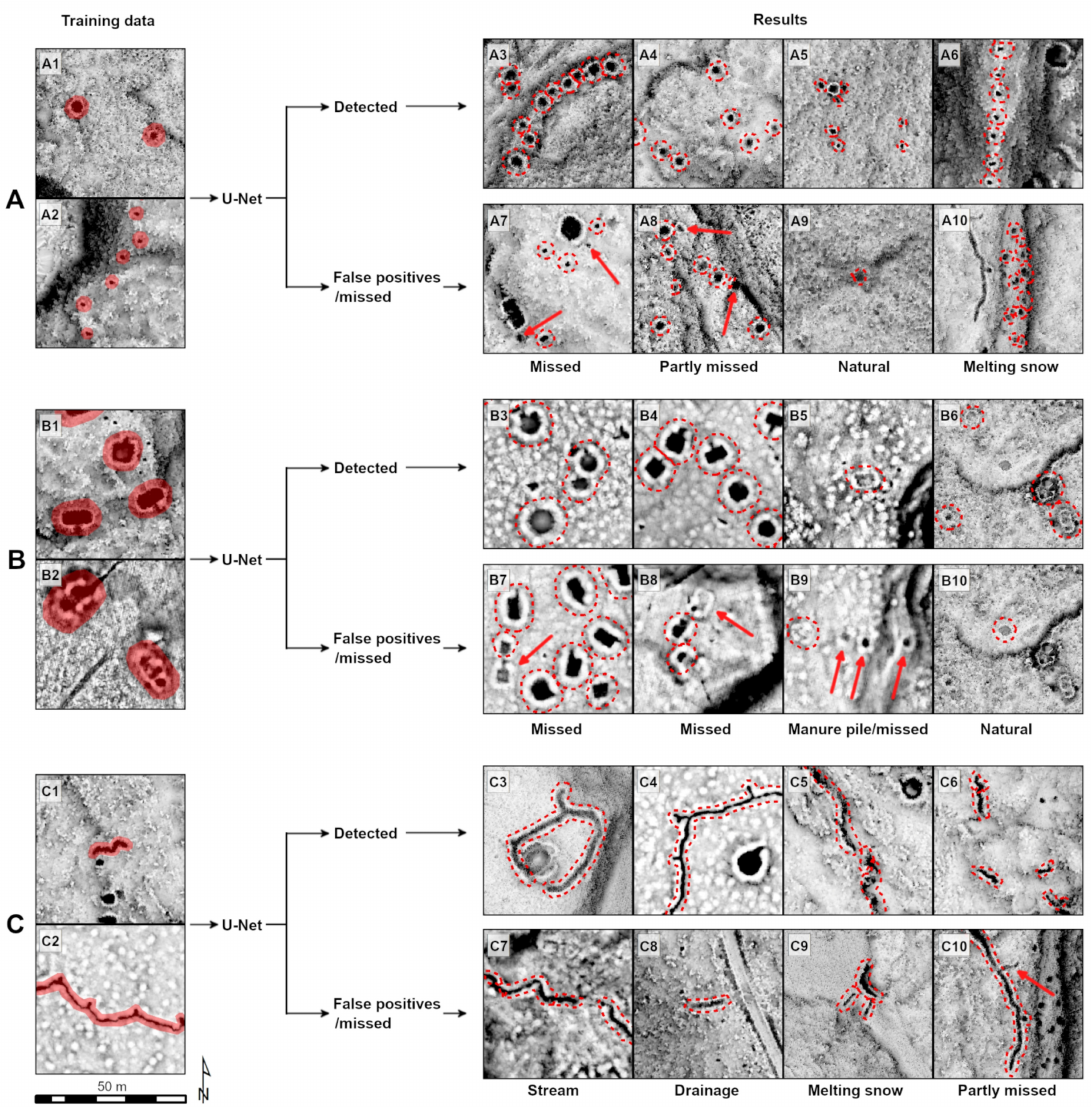
Figure 6. Examples of the U-Net detector D1–3 training data and detection results (here based on SVF visualizations, examples from all case study areas). ( A1 – A10 ) Detector-1. Smaller (diam. < 5 m), roughly round pit features with shallow embankments, such as pitfalls, foxholes, and rubbish pits. ( B1 – B10 ) Detector-2. Larger (>5 m), more amorphous shallow pit features with shallow embankments, such as S á mi turf hut floors and German Second World War dugouts and tent places. ( C1 – C10 ) Detector-3. Linear features, namely German Second World War trenches. (Illustration: Oula